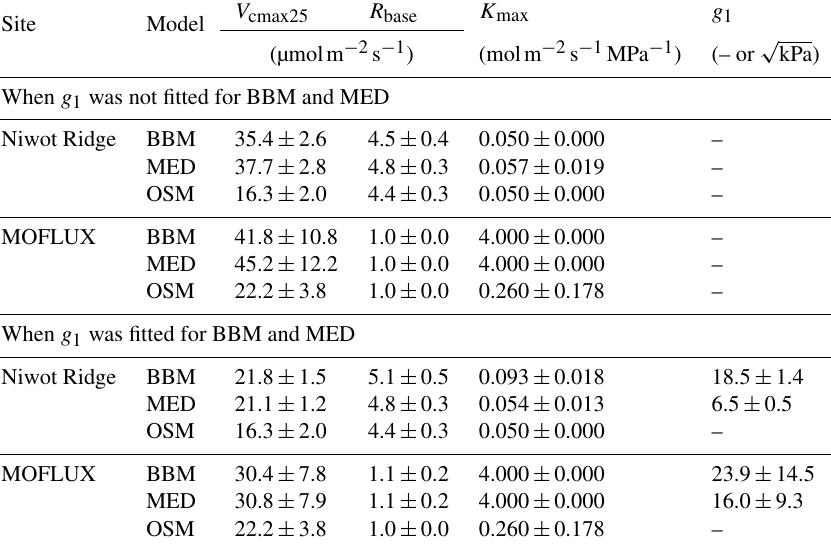
Table 3. Fitting parameters of the three stomatal models: the Ball et al. (1987) model (BBM), the Medlyn et al. (2011) model (MED), and the Wang et al. (2020) model (OSM). Numbers shown in the table are the mean ± standard deviation. The fitted parameters include the following: the maximum carboxylation rate at 25 ◦ C ( V cmax25 ), root respiration at 25 ◦ C ( R base ), the maximal tree hydraulic conductance √ per basal area ( K max ), and the empirical stomatal parameter g 1 (unitless for BBM, in kPa for MED).